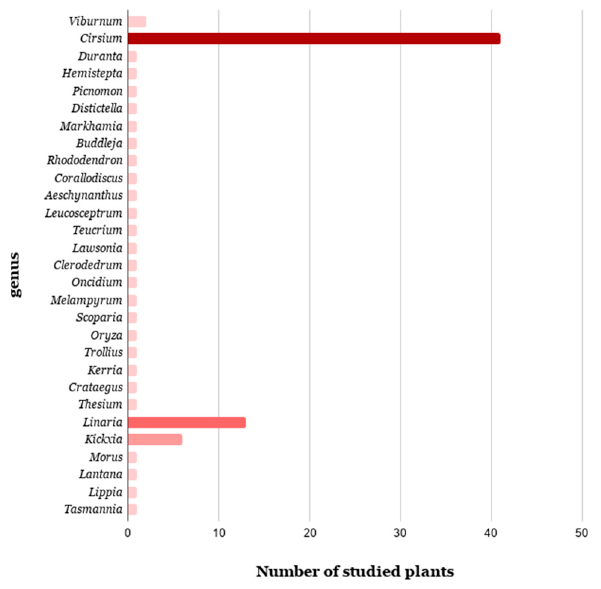
Figure 2. Number of plants investigated for the presence of pectolinarin, classified according to their genus.